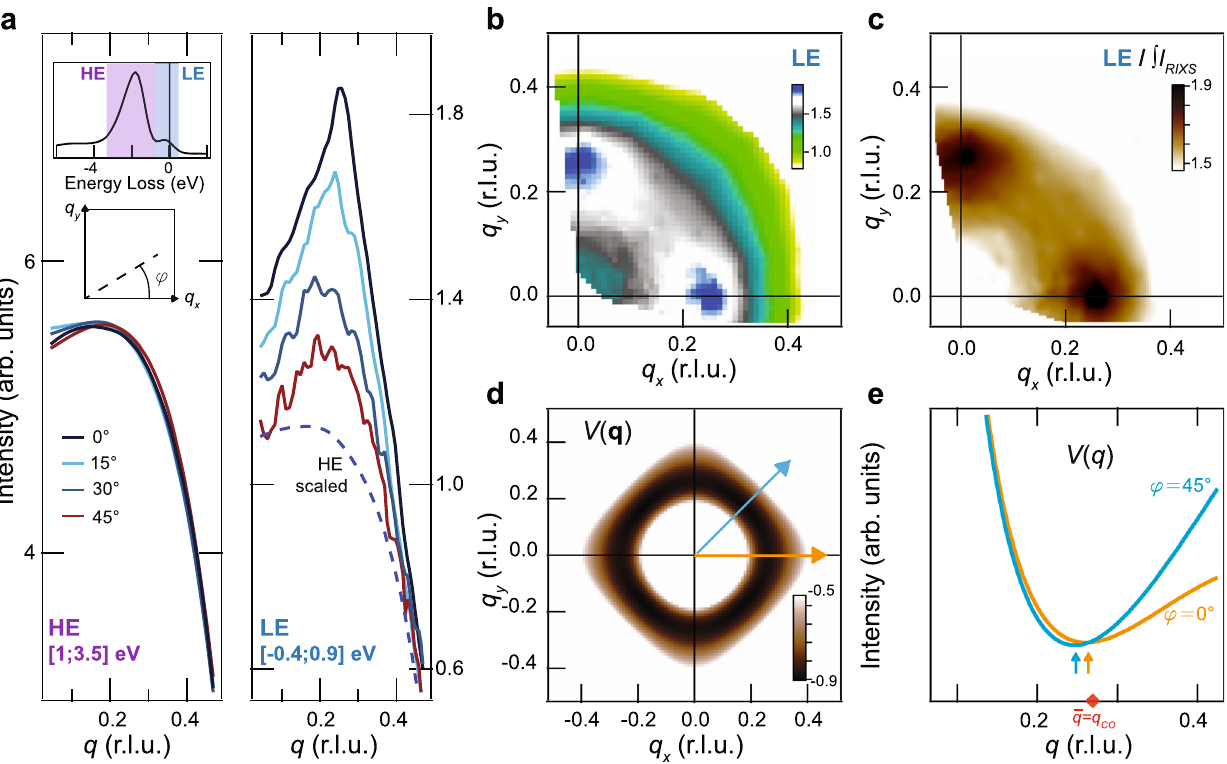
Fig. 1 The natural tendency for Coulomb interactions to cause a quasi-circular in-plane scattering pattern. a RIXS scattering measured at 50 K as a function of momentum along different φ , obtained by integrating the energy loss spectra over the high-energy ( E > 0.9 eV, HE) and low-energy ( E < 0.9 eV, LE) regions. The inset displays the Cu-L 3 RIXS energy-loss spectrum for q ≈ 0.05 rlu and φ = 0 ∘ . The blue dashed line compares the featureless and φ -independent HE scattering signal to the LE curves. b CO structure in the q x – q y plane integrated over the LE region for 50 K. c Similar to ( b ) with LE data normalized to the total fl uorescence, i.e., the RIXS spectrum integrated in the [ − 4,25] eV energy range ( ∫ I RIXS , details in Supplementary Note 2). d The structure of the Coulomb interaction V ( q ) calculated using known parameters for Bi2212 (details in Supplementary Note 4). e Line cuts of ( d ) along φ = 0 ∘ and 45 ∘ , as indicated by the blue and orange arrows. The red diamond in e indicates the experimentally determined q = q CO